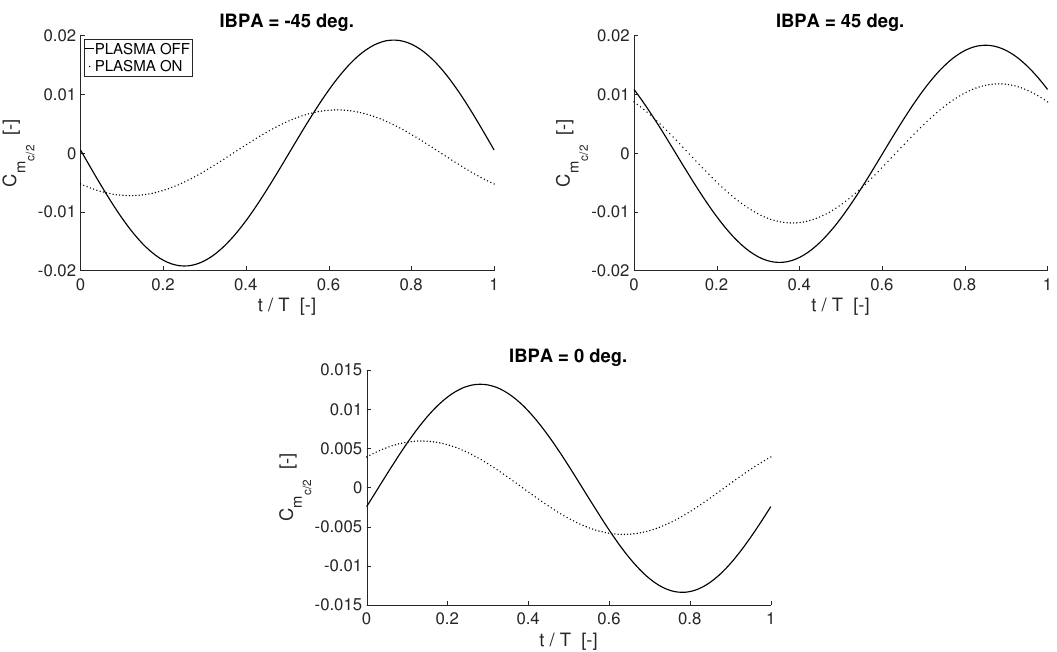
Figure 14. Time history of the mid-chord pitching moment coefficient C m last simulated period; Re ∼ 195,000; α = 2 + sin ( 2 π f t + 4 × IBPA π IBPA = [ ± 45,0 ] degrees.